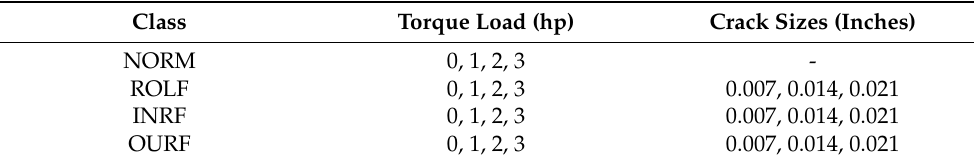
Table 1. Case Western Reserve University Vibration Dataset classes, torque loads, and crack sizes [38]. Class Torque Load (hp) Crack Sizes (Inches) NORM 0, 1, 2, 3 - ROLF 0, 1, 2, 3 0.007, 0.014, 0.021 INRF 0, 1, 2, 3 0.007, 0.014, 0.021 OURF 0, 1, 2, 3 0.007, 0.014,